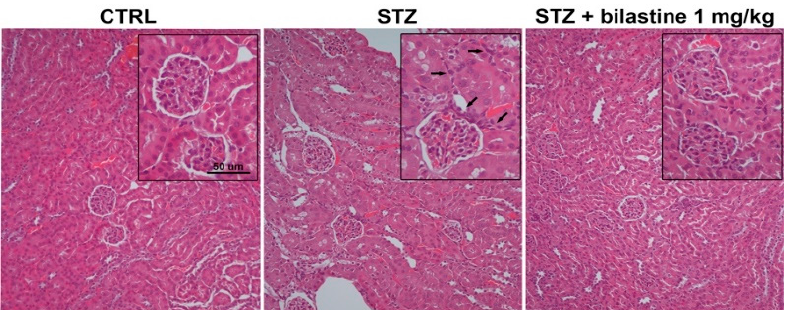
Figure 7. Effect of bilastine on tubular interstitial infiltration. May–Grünwald–Giemsa staining from renal sections. Micrographs at 20× or 40× (insert) magnification are representative of 10 animals/group.